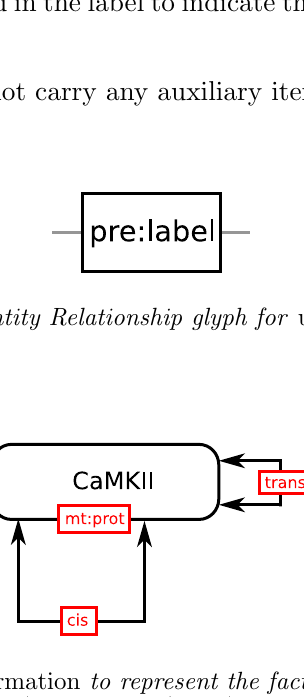
Figure 2.33: Using units of information to represent the fact that the entity “CaMKII” is a protein, and to display intra- (cis) and inter- (trans) molecular